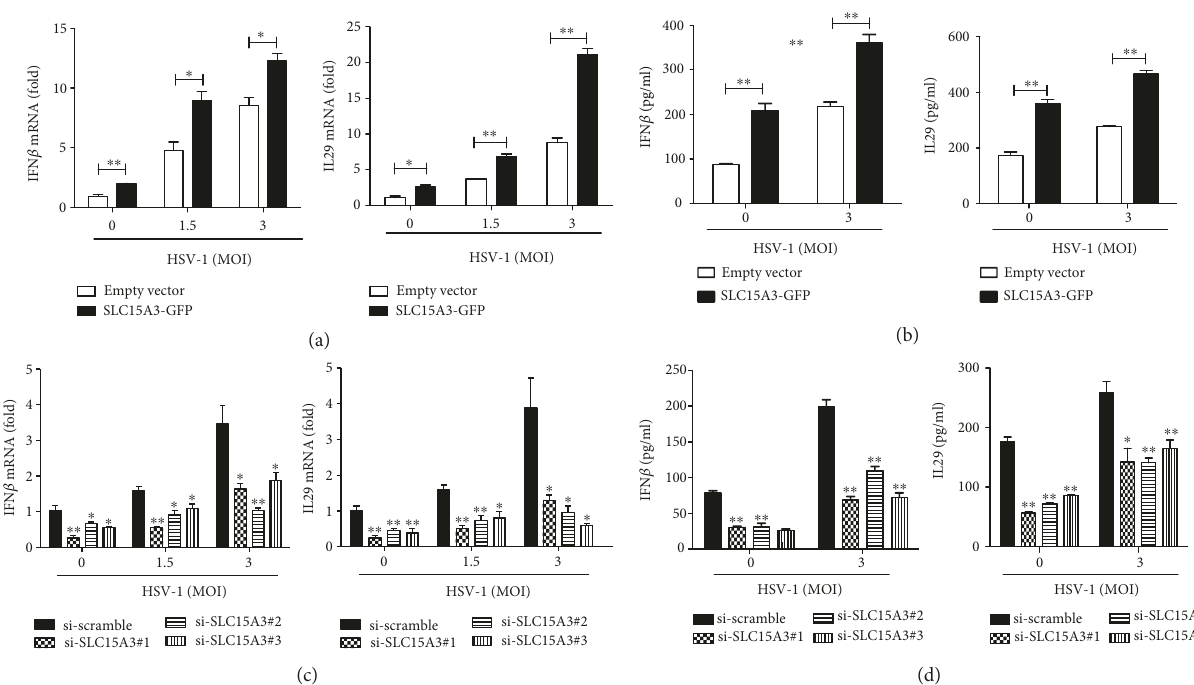
Figure 4: SLC15A3 enhances HSV-1-mediated IL29 and IFN β induction. (a) qRT-PCR analysis of IFN β and IL29 in 293T transfected with empty vector and SLC15A3-GFP plasmids for 16 h and then incubated with HSV-1 at indicated MOI of HSV-1 for 24h. (b) ELISA detection of IFN β and IL29 in cell culture supernatants collected from 293T transfected with empty vector and SLC15A3-GFP plasmids followed by HSV-1 incubation. (c) qRT-PCR analysis of IFN β and IL29 in 293T transfected with scrambled and SLC15A3 siRNA for 24h and then incubated with HSV-1 at indicated MOI of HSV-1 for 24h. (d) ELISA detection of IFN β and IL29 in cell culture supernatants collected from 293T transfected with scrambled and SLC15A3 siRNA for 24h and then incubated with HSV-1 at indicated MOI of HSV-1 for 24h. ∗ P < 0 05 , ∗∗ P < 0 01 (unpaired t -test). Data (mean ± sd) are representative of three experiments with similar